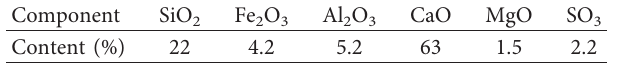
Table 1: Chemical composition of cement.